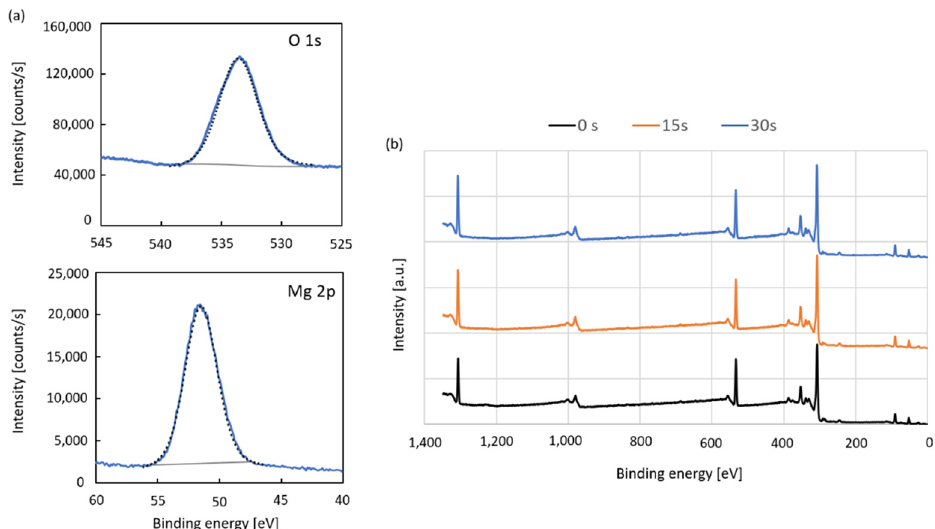
Figure 7. XPS results collected from a sample of MgO obtained from batch III fraction I: ( a ) detailed regions: O 1s and Mg 2p (without prior etching) and ( b ) survey spectra at three different etch levels: 0 s, 15 s and 30 s.